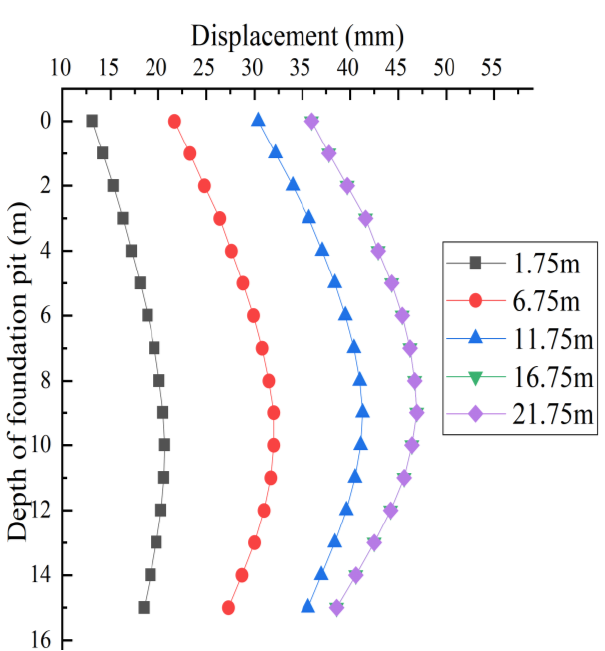
Figure 15. Pile displacement behavior.